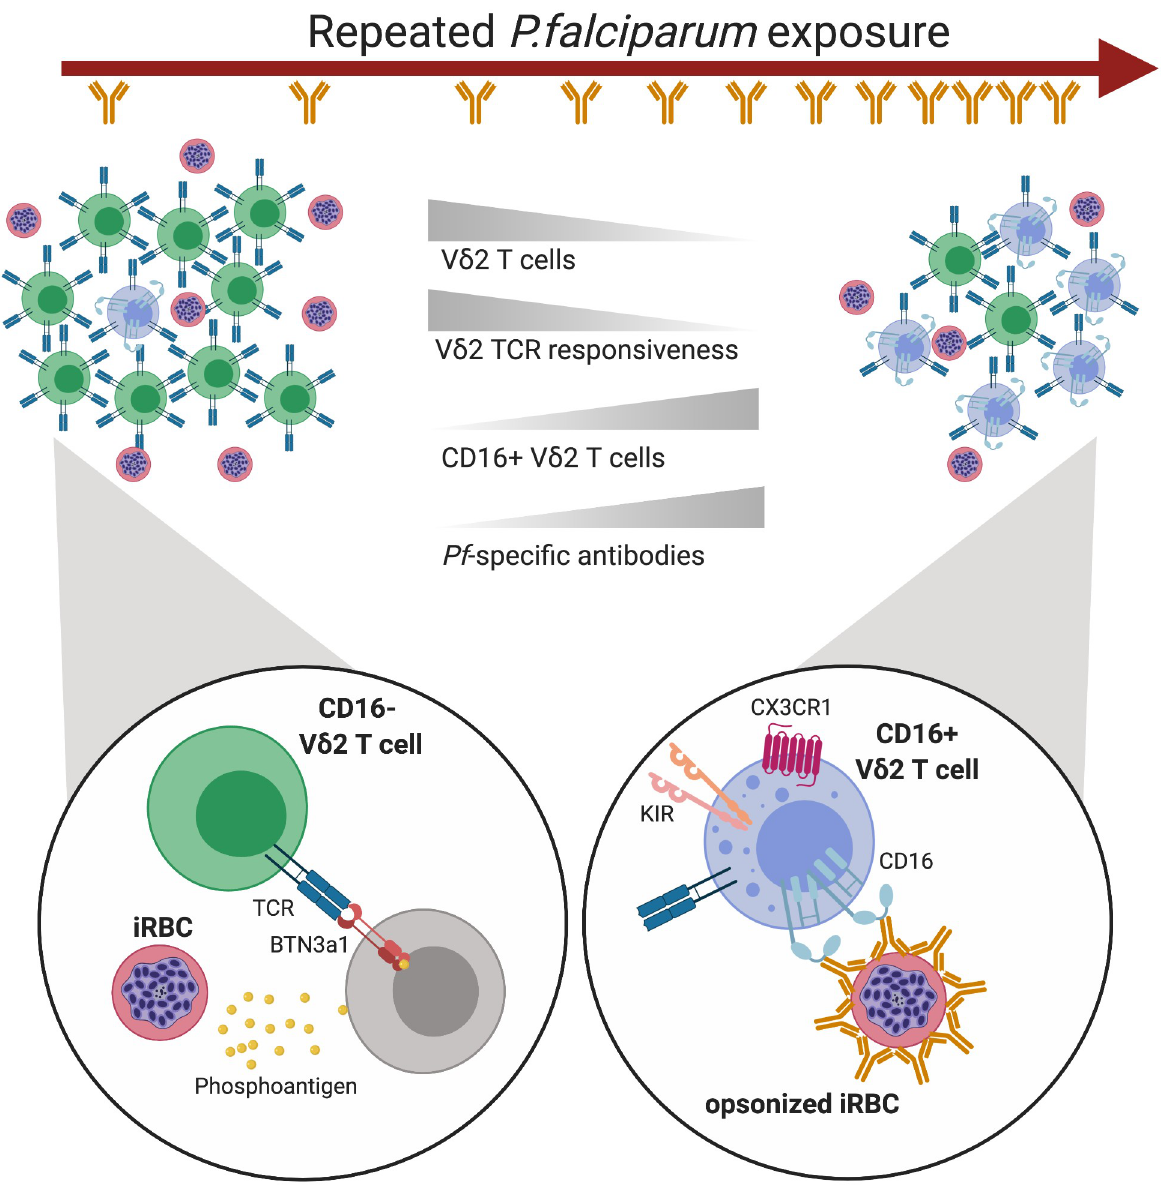
Fig 6. Model of V δ 2 T cells over the course of repeated Pf infection. As an individual experiences more episodes of Pf , the frequency of V δ 2 T cells in their peripheral blood declines. Remaining V δ 2 T cells become less responsive through their TCRs while the frequency of CD16 + expression increases. These changes occur while an individual’s anti- Pf antibody response is simultaneously growing and diversifying, presumably providing more opsonized parasite targets for CD16+ V δ 2 T cells. TCR-responsive V δ 2s are activated by engagement with BTN3A1 on another cell, probably a lymphocyte, when BTN3A1’s conformation is altered by the intracellular binding of parasite-derived phosphoantigens. CD16-responsive V δ 2 T cells are activated by opsonized parasite antigen and may have their activation threshold modulated by KIR expression and engagement. Created with